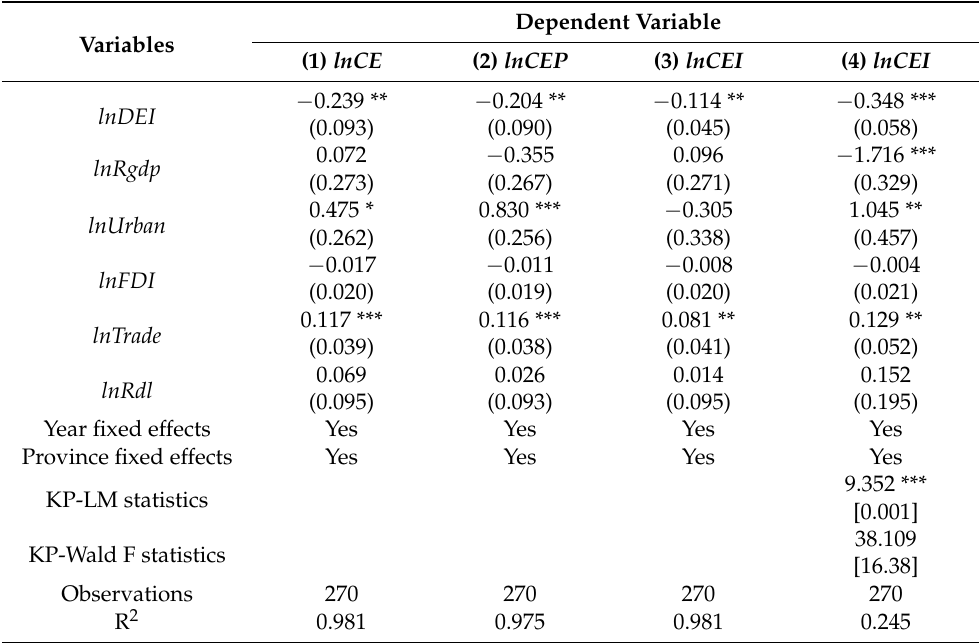
Table 6. Robustness test of the effect of digital economy on environmental